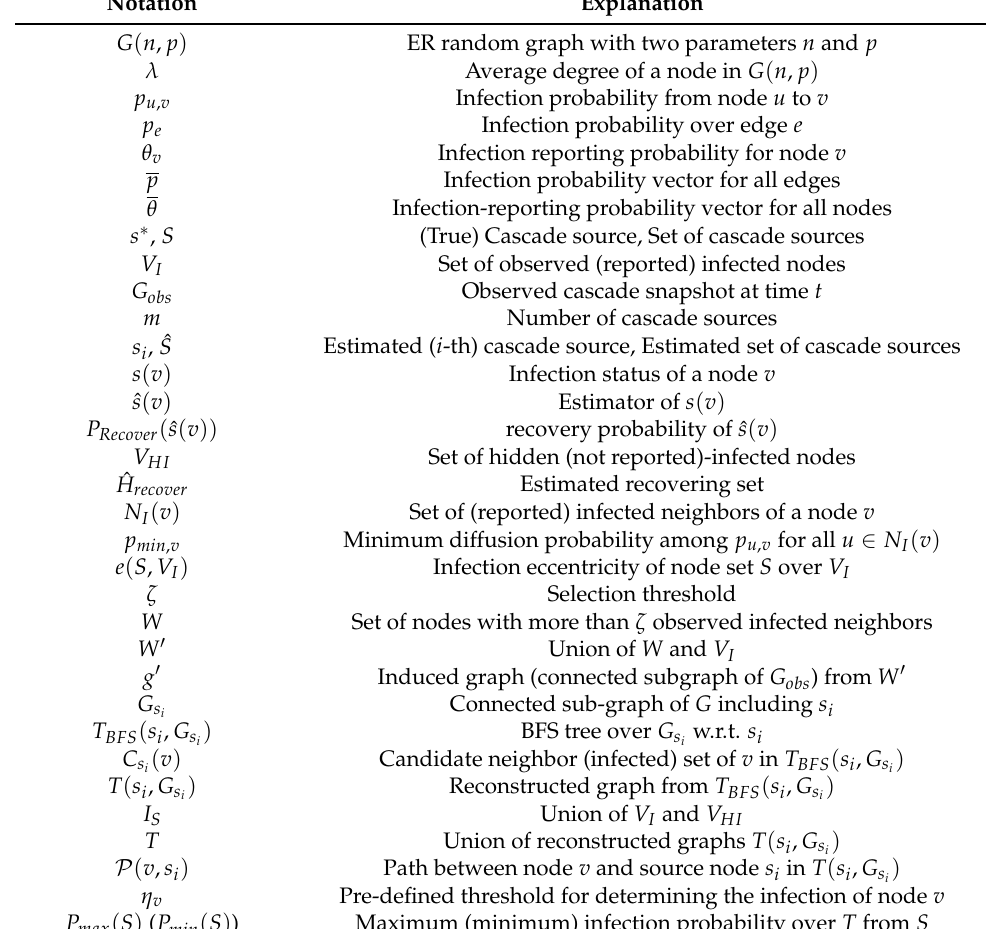
Table 1. Summary of